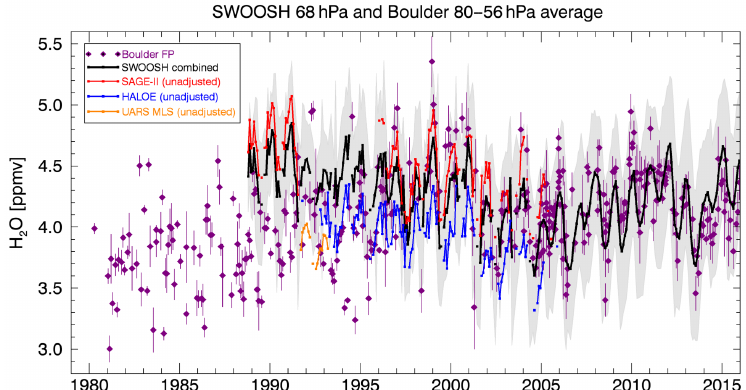
Figure 16. The SWOOSH combined (unfilled) record at 68hPa and 35–45 ◦ N (black line) along with the Boulder NOAA frost point hygrometer record averaged from 80 to 56hPa (purple diamonds). Error bars for the Boulder data are 2 standard errors ( ∼ 95% confidence interval) of the mean within the layer, and the shaded area for SWOOSH shows twice the standard deviation of the combined (unfilled) product. The unadjusted satellite source record time series at 68hPa and 35–45 ◦ N are also shown (colored lines and